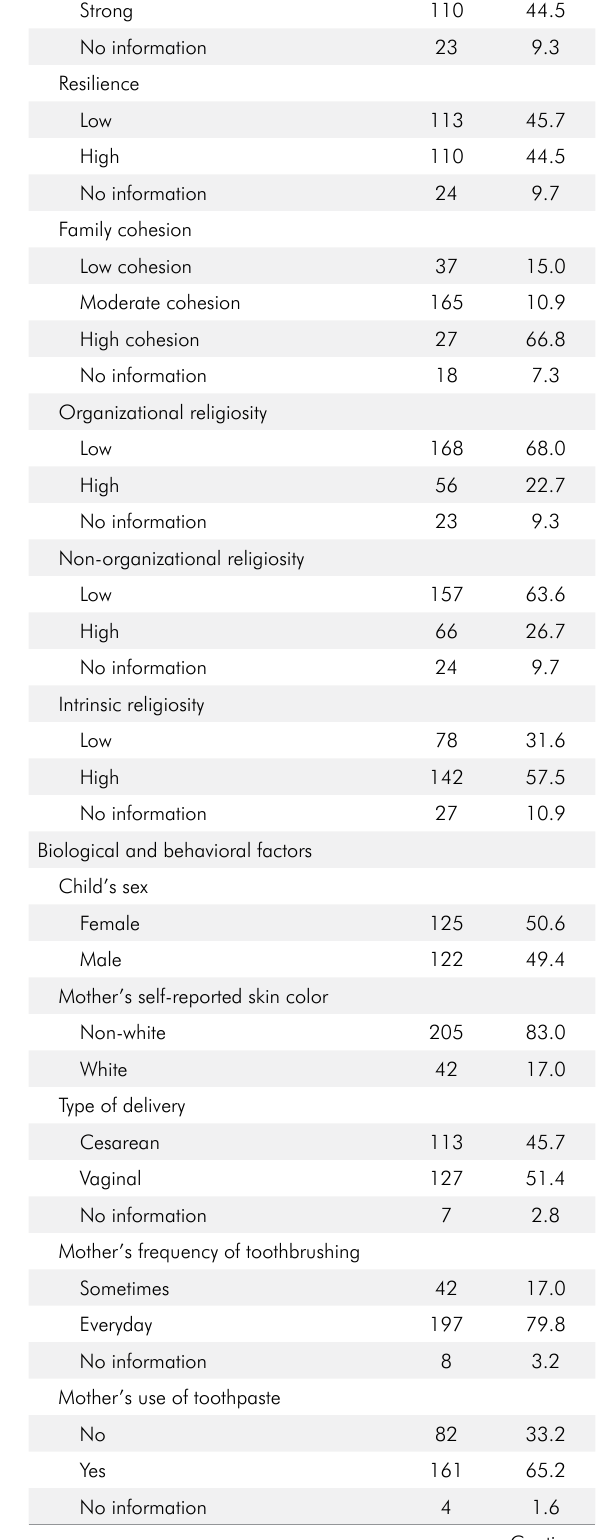
Table 1. Frequency distribution of socioeconomic, psychosocial, biological, and behavioral factors among 5-year-old